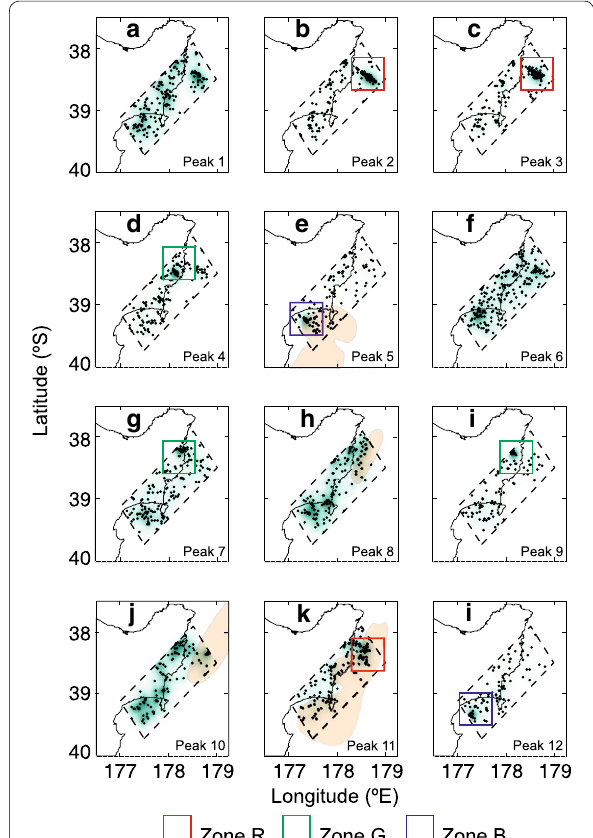
Fig. 9 Spatial locations of earthquakes associated with peaks in the estimated background rate. Epicenters of earthquakes corresponding to each seismicity peak identified in Fig. 8e are plotted. These scatter plots are visually enhanced by adding color based on smoothed his- togram as described in Eilers and Goeman (2004). Also plotted, where available, are the slip regions of the associated slow slip earthquakes. Distinct spatial zones where prominently identifiable seismicity clusters seem to occur are shown as colored rectangles (red, blue and